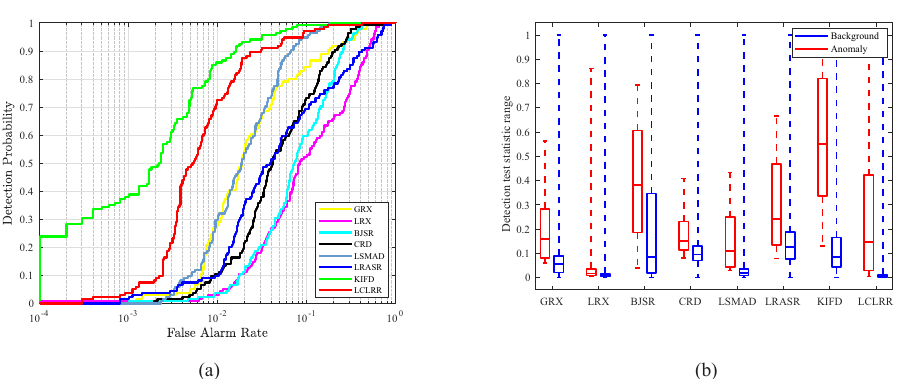
Figure 6. The ROC curves and box plots of different algorithms for the San Diego airport dataset. ( a ) ROC curve. ( b ) box